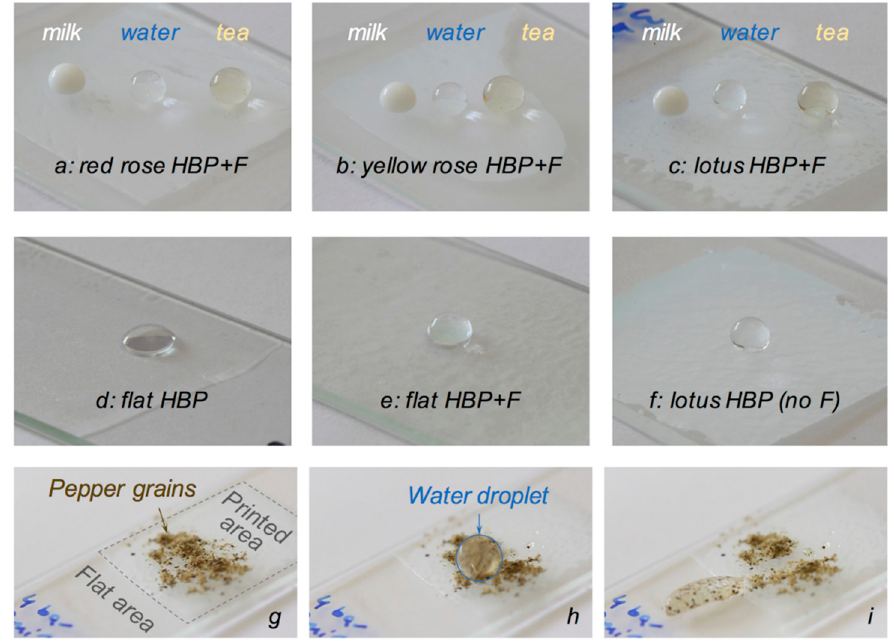
Figure 8. Behavior of milk, water and tea on the surfaces of flat and printed HBP and fluorinated HBP (HBP + F) coatings on glass slides (liquid droplets on HBP + 5 wt. % PFUA with 2 h air exposure and 0.2 s UV flash replica of ( a ) red rose; ( b ) yellow rose and ( c ) lotus; water droplets on ( d ) flat HBP; ( e ) flat HBP + 5 wt. % PFUA with 24 h air exposure; ( f ) lotus replica of pure HBP) and demonstration of the self-cleaning properties of a lotus replica (HBP + 5 wt. % PFUA with 2 h air exposure and 0.2 s UV flash) using water and pepper grains; ( g ) before cleaning with water; ( h ) with a water droplet (highlighted with a blue circle) running on the pepper contaminated surface and ( i ) after cleaning, with water droplet loaded with pepper particles and immobilized on the non-printed, flat area, leaving a clean trace on the printed surface.